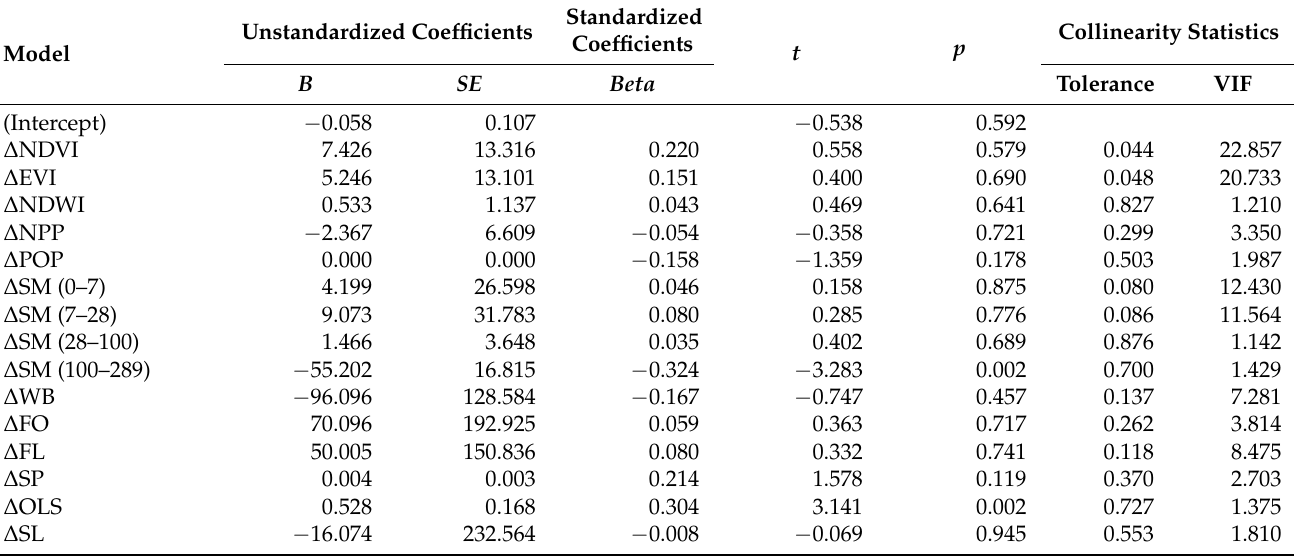
Table 2. Multicollinearity diagnosis of the driving factors. Dependent variable: ∆ AST. The definitions of the abbreviated variables can be found in Table 1.